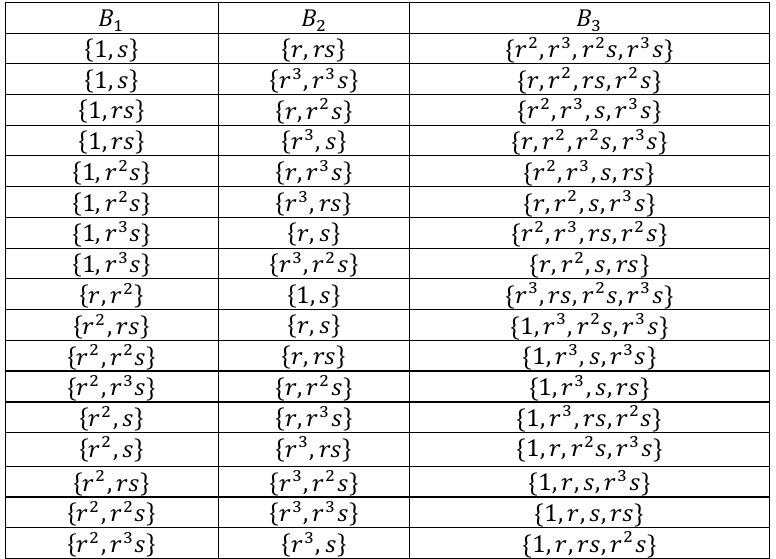
Table 1. List of complete decompositions of 𝐷 8 of order 3, where 𝐵 1 , 𝐵 2 , 𝐵 3 ⊆ 𝐷 8 and 𝐵 1 𝐵 2 𝐵 3 ≠ 𝐵 2 𝐵 1 𝐵 3